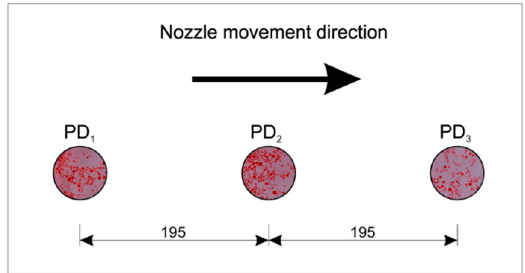
Figure 5. Positioning of the Petri dishes (PD) on the table of the test bench (sizes in mm).